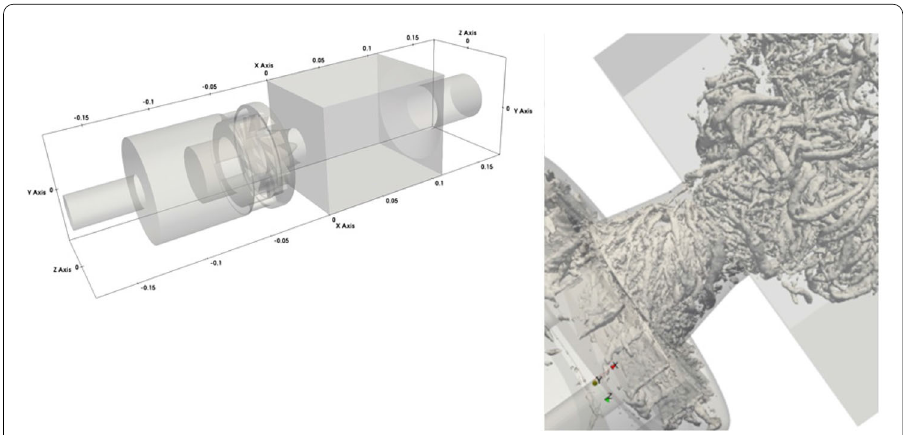
Fig. 11 The 3D unsteady turbulent and incompressible flow in a fuel injection system and in the primary zone of the combustion chamber, given a constant inlet velocity, an outlet boundary condition on the channel outlet and a wall boundary condition on the upper and lower walls of the channel